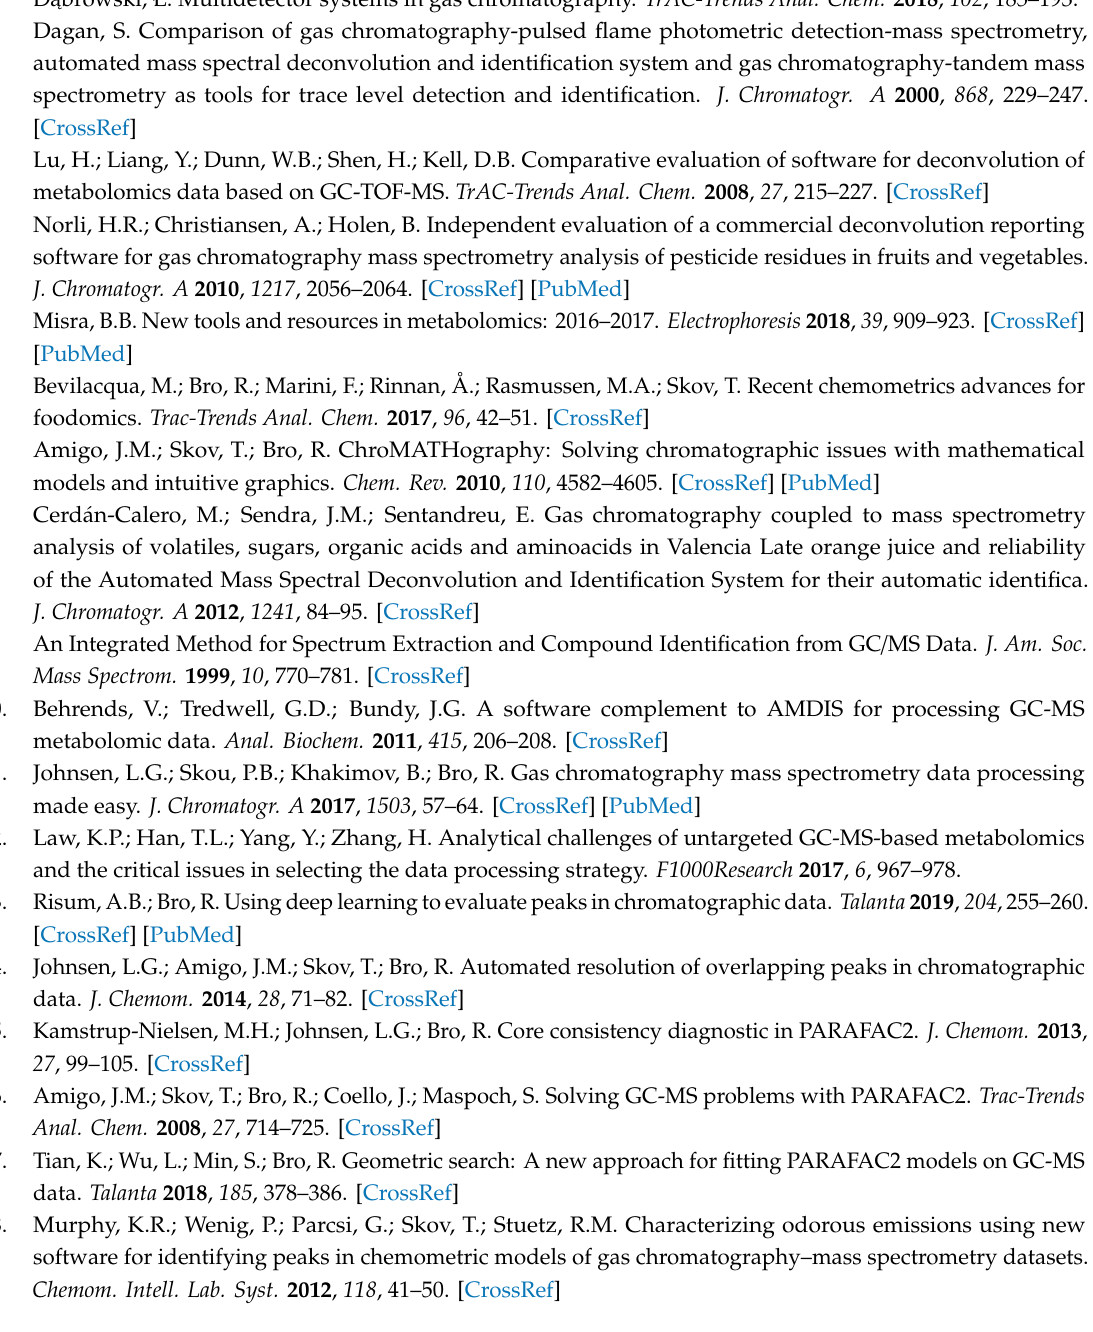
Figure S1: E ff ect of denoising filter on chromatograms: five chromatograms (sample S3) imported as CDF files into PARADISe program A) without the denoising filter B) with the denoising filter applied